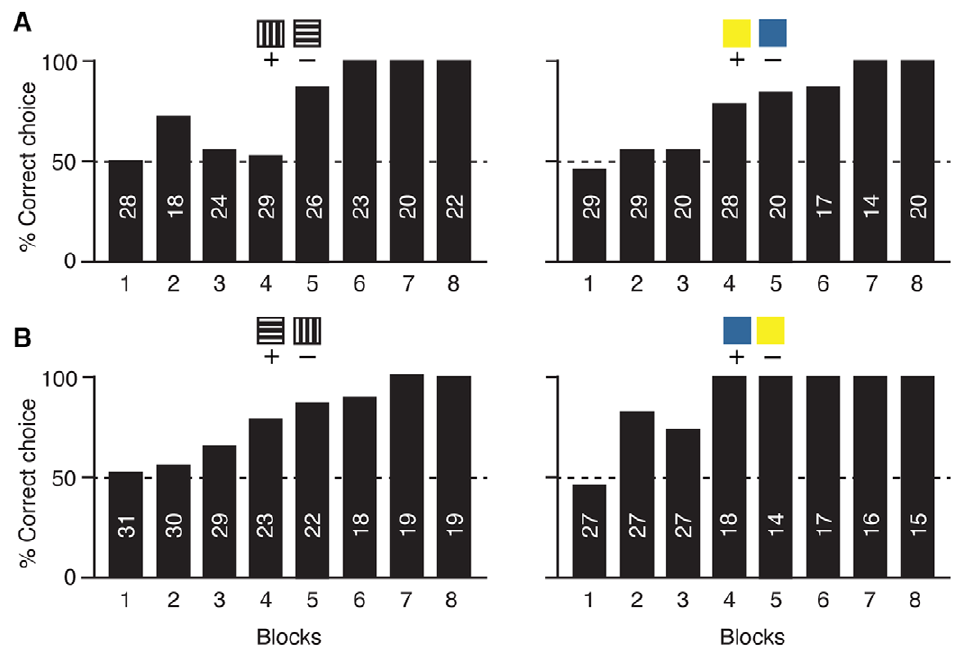
Figure 4. Discrimination learning in Meliponarufiventris stingless bees. Bars: percentage of correct choices in eight consecutive training blocks, during which bees learnt to discriminate a vertical pattern from a horizontal pattern, and yellow from blue. One group of 8 bees was trained with vertical and yellow as rewarded stimuli (A), and a second group of 8 bees was trained with horizontal and blue as rewarded stimuli (B). The learning criterion was 100% correct choices in at least two consecutive blocks. Numbers inside bars indicate the total number of choices per session.